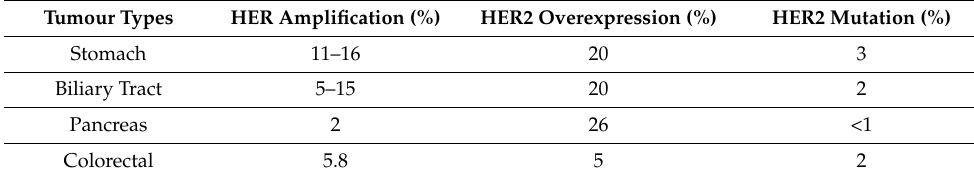
Table 1. Distribution of HER2 amplifications, overexpression, and mutation in gastrointestinal (GI) tumors